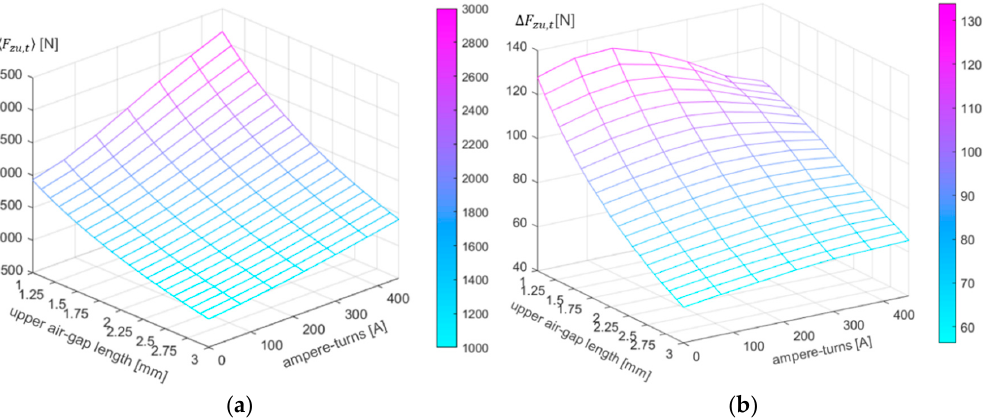
Figure 12. Force components developed by the AHMB upper side as functions of g u and A u ; ( a ) force at the mean temperature; ( b ) differential force.